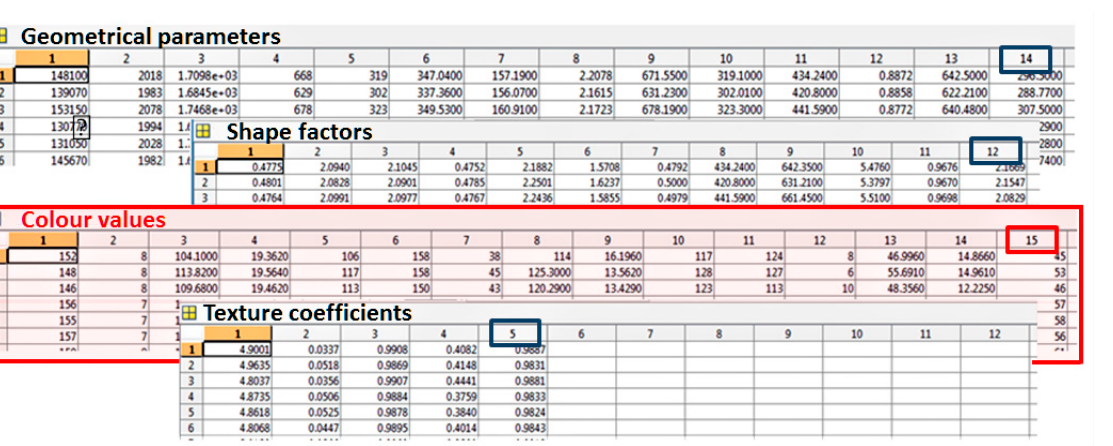
Figure 6. The design of four training sets of the MATLAB Neural Network Toolbox . A block diagram showing the neural model generated using the Neural Network Toolbox (MATLAB) is shown in Figure 7.